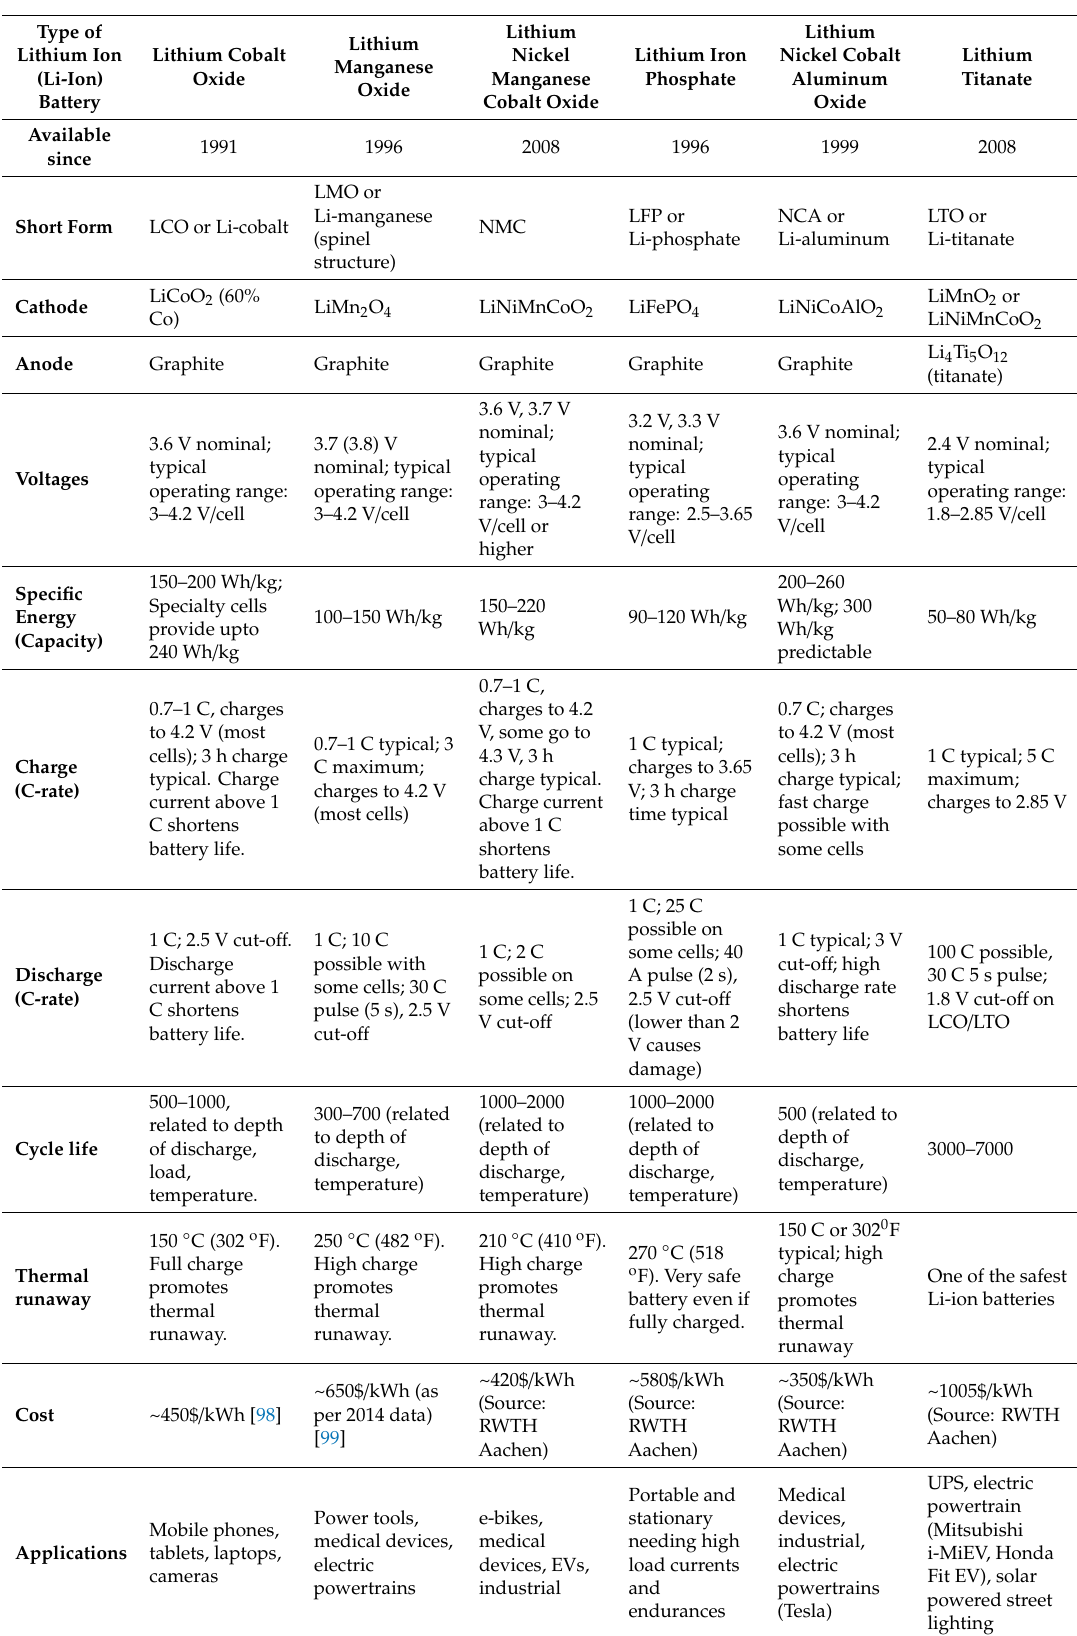
Table 8. Di ff erent Li-ion batteries and their characteristics